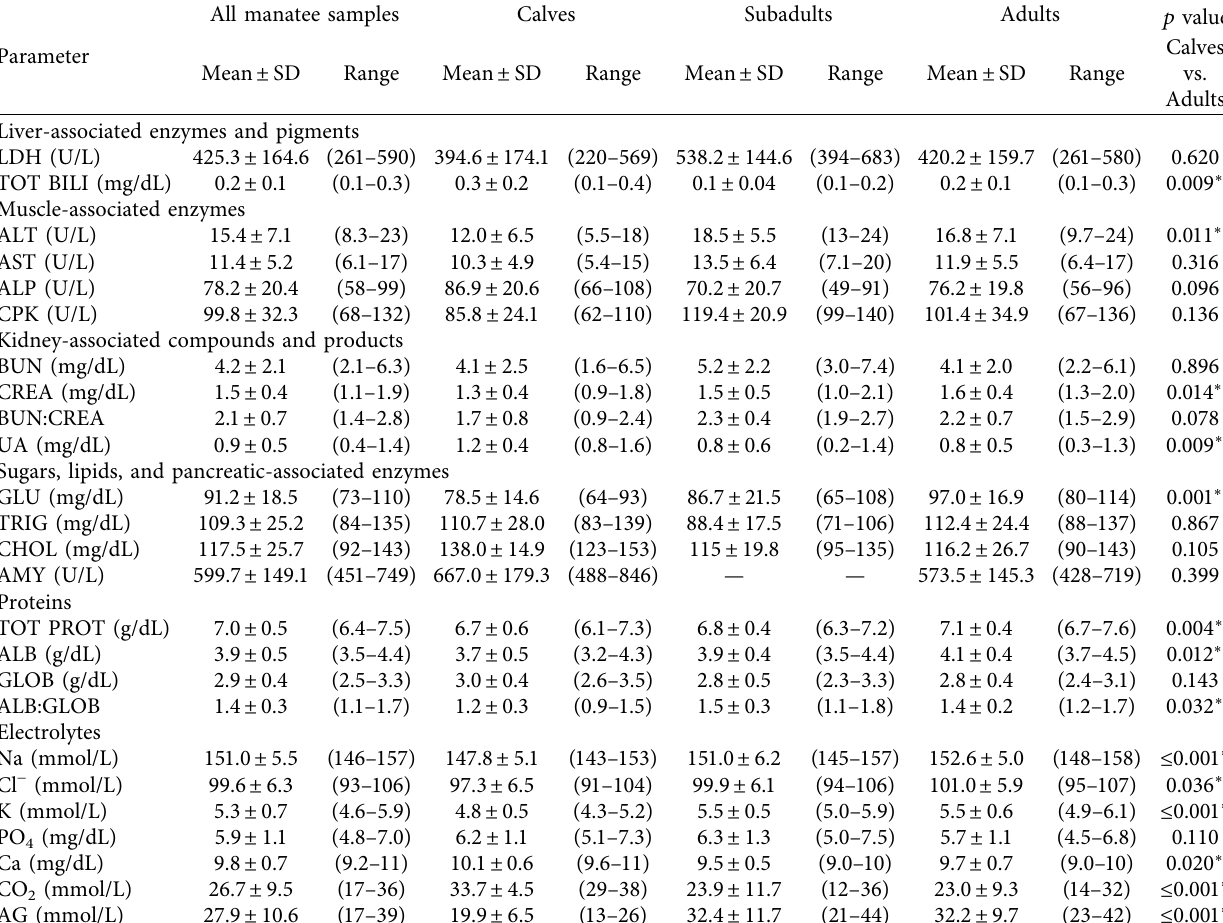
Table 4: Mean serum chemistry values for manatees from Puerto Rico for all samples (calves, subadults, and adults, n � 70): calves only, n � 23; subadults only, n � 6; and adults only, n � 41, with ± 1 standard deviation range in parentheses. Abbreviations for parameters are detailed in the Materials and Methods section. Significant differences using p values between calves and adults are indicated with an asterisk ( ∗